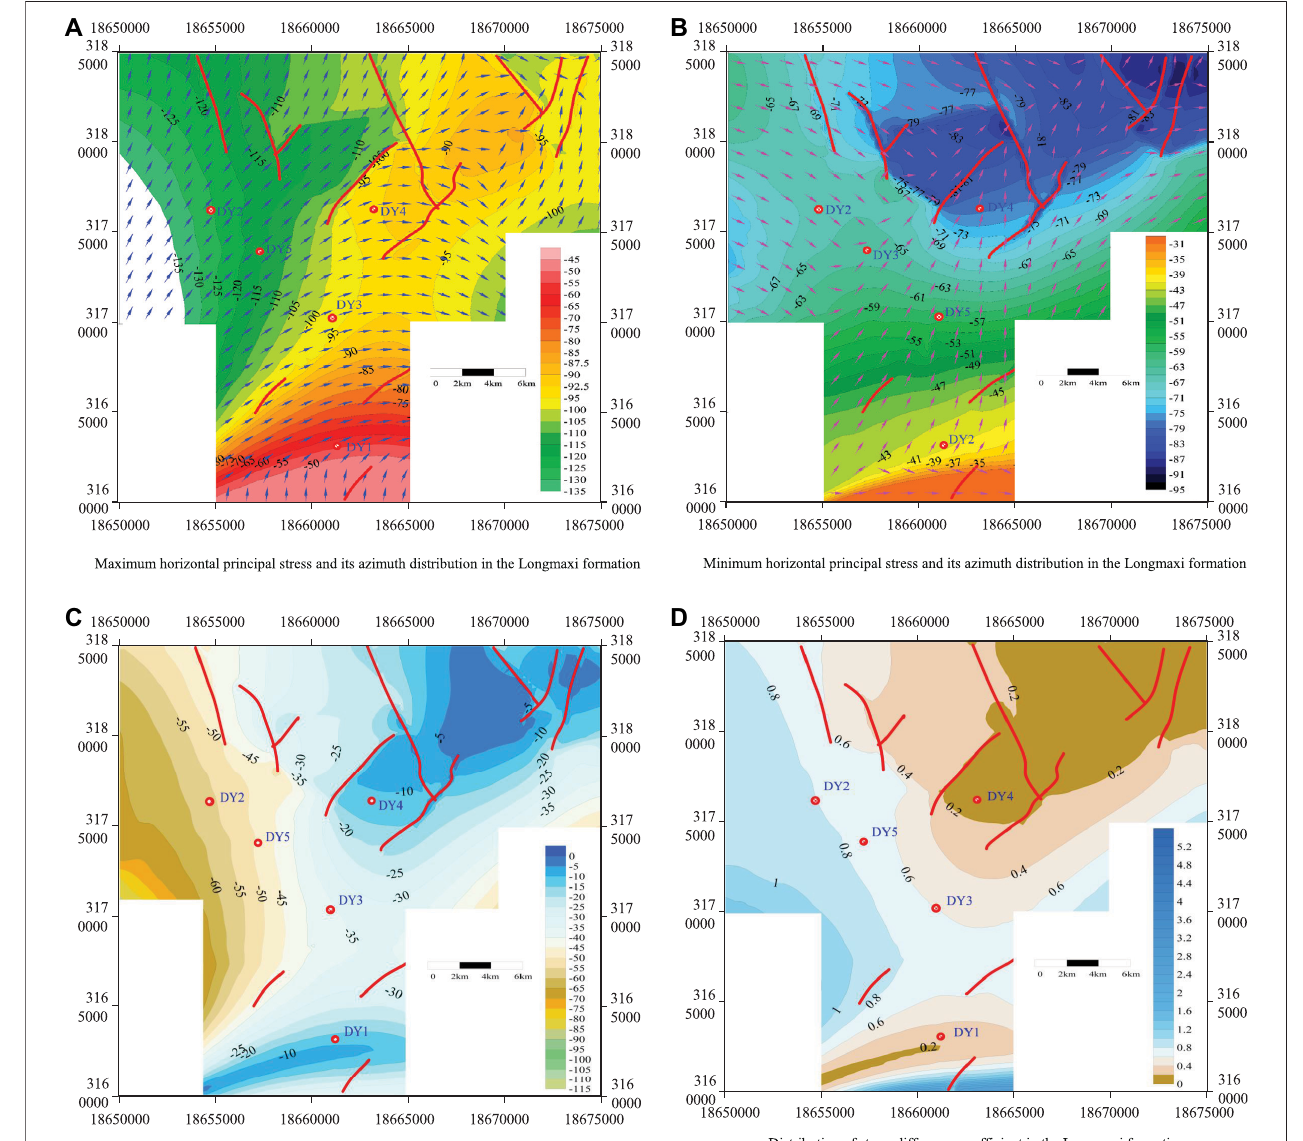
Frontiers in Earth Science |